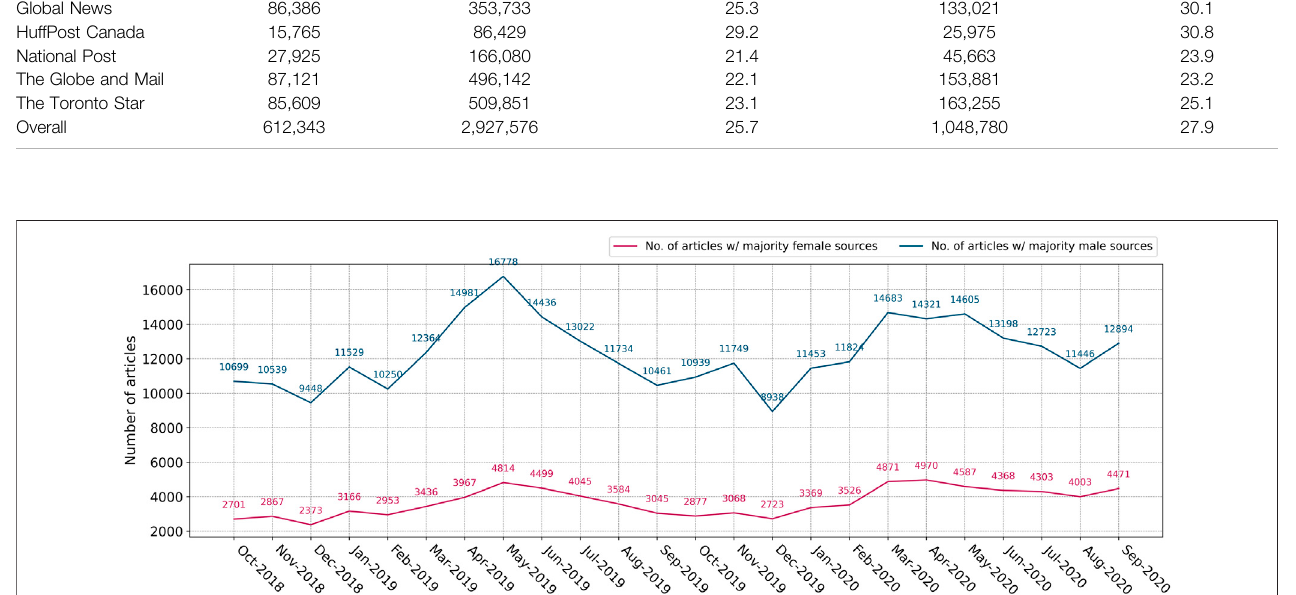
FIGURE 1 | Monthly counts of articles that contain majority male/female